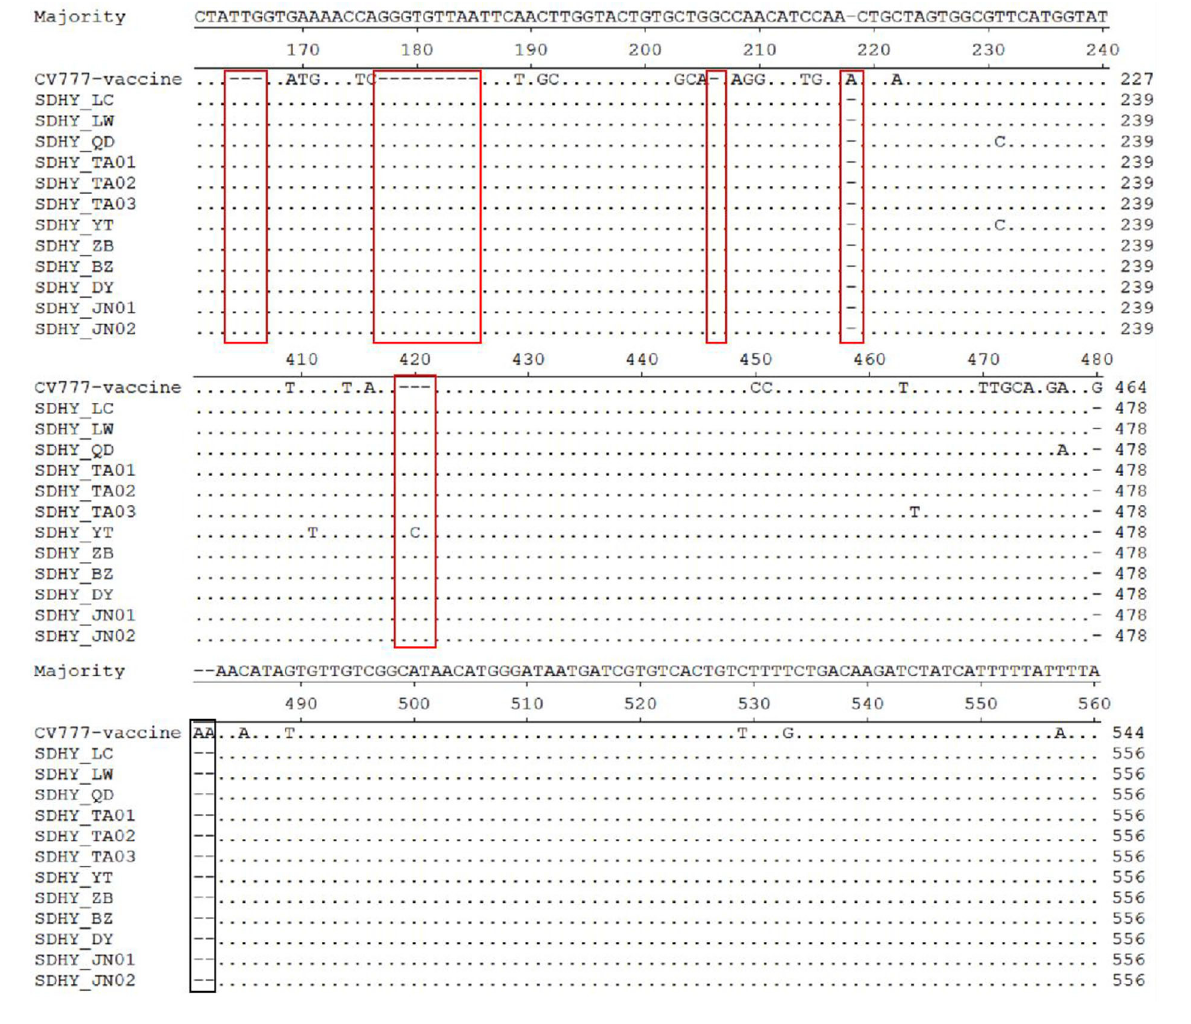
FIGURE4 Analysis and comparison of nucleotide of the partial S